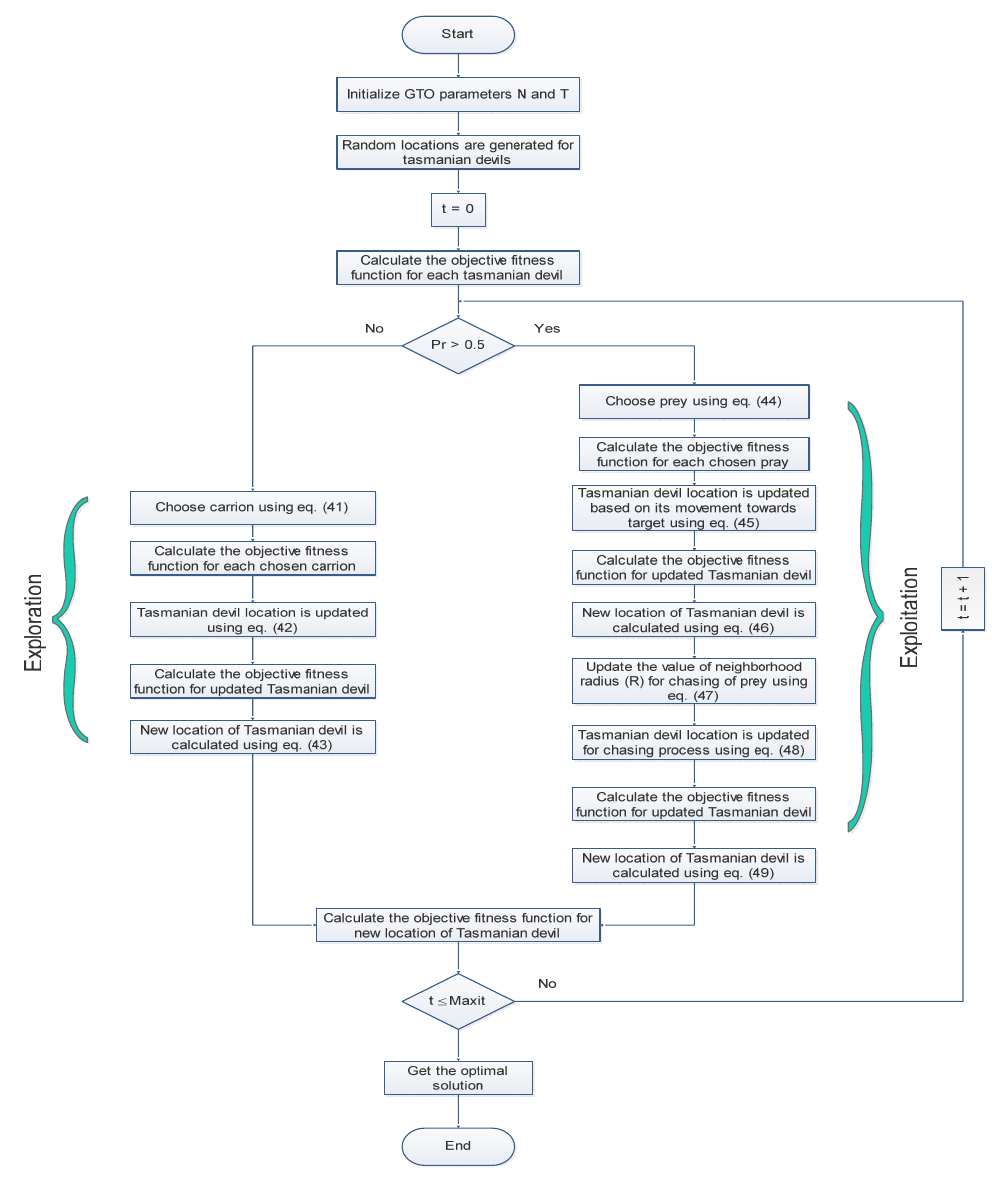
Figure 2. Flow chart of the TDO algorithm to solve the problem of